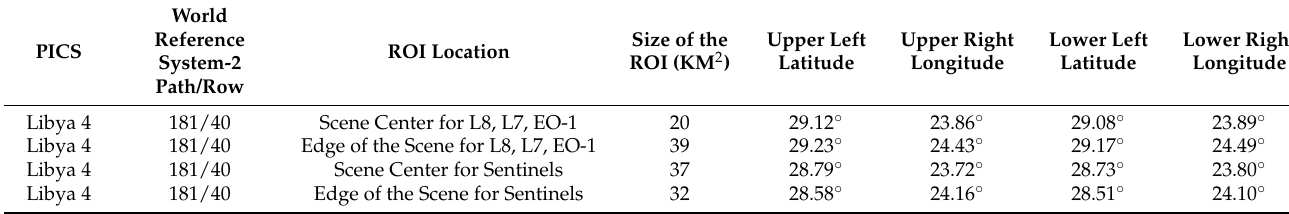
Figure 1. ( a ) Image of Landsat 8; ( b ) image of Hyperion EO-1 over Libya 4 PICS; ( c ) SDSU IPLab Optimal Region of 3% stability (white masks) and the selected scene centered region of interests (red) for Landsat 8, EO-1 Hyperion, and Sentinel footprints; ( d ) selected region of interests (green) at the edge of the scene in Optimal Region for Landsat 8, EO-1 Hyperion and Sentinel footprints. Table 2. Optimal region of interest (ROI) latitude and longitude